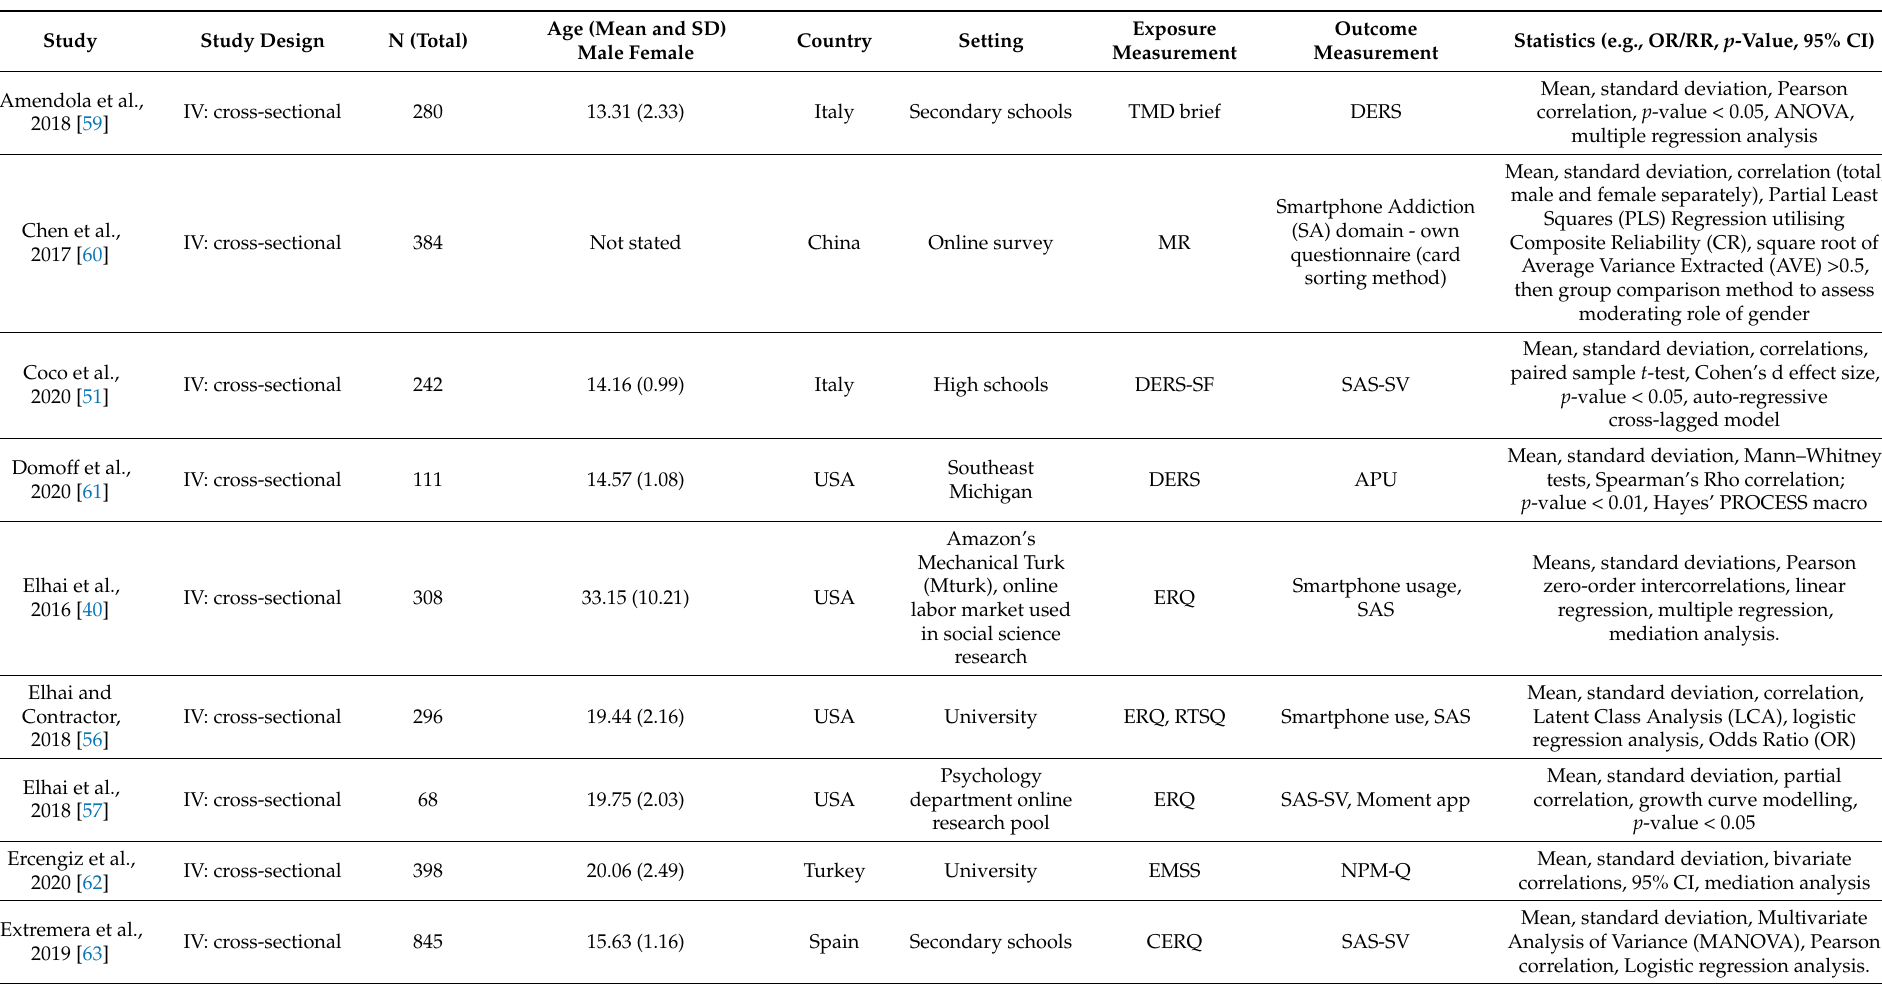
Table A1. Characteristics of included